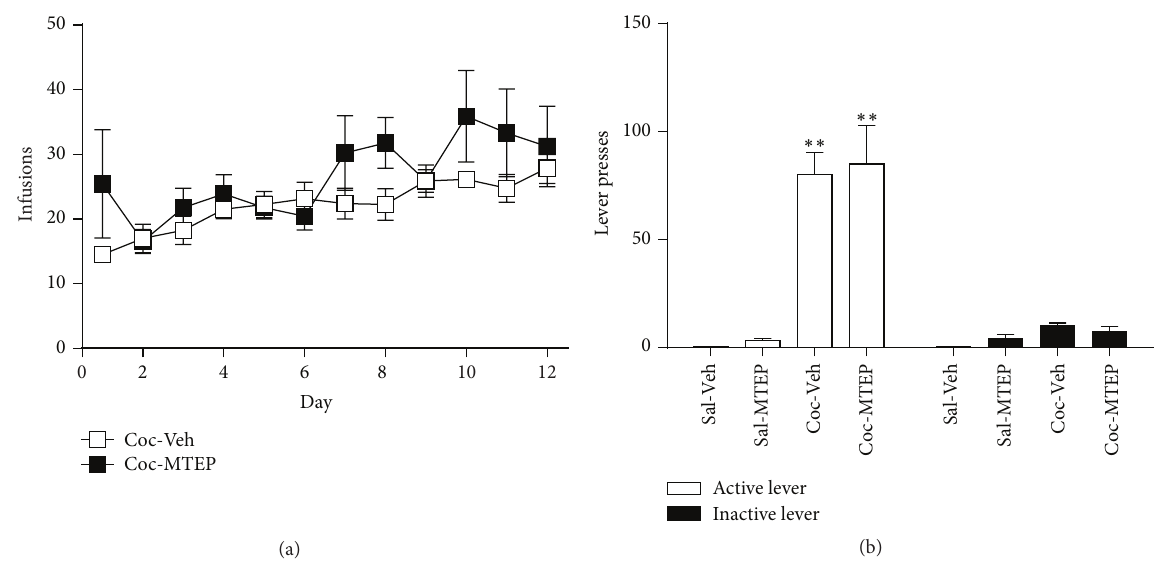
Figure 2: Intra-dlSTR infusion of MTEP does not attenuate context-primed relapse. (a) Mean infusions during the self-administration period did not differ between groups later given MTEP (5 𝜇 g) or vehicle during the relapse test. (b) Animals that self-administered cocaine relapsed upon placement in the self-administration context following abstinence while those receiving yoked-saline infusions did not. MTEP did not alter relapse. ∗∗ 𝑝 < 0.001 compared to